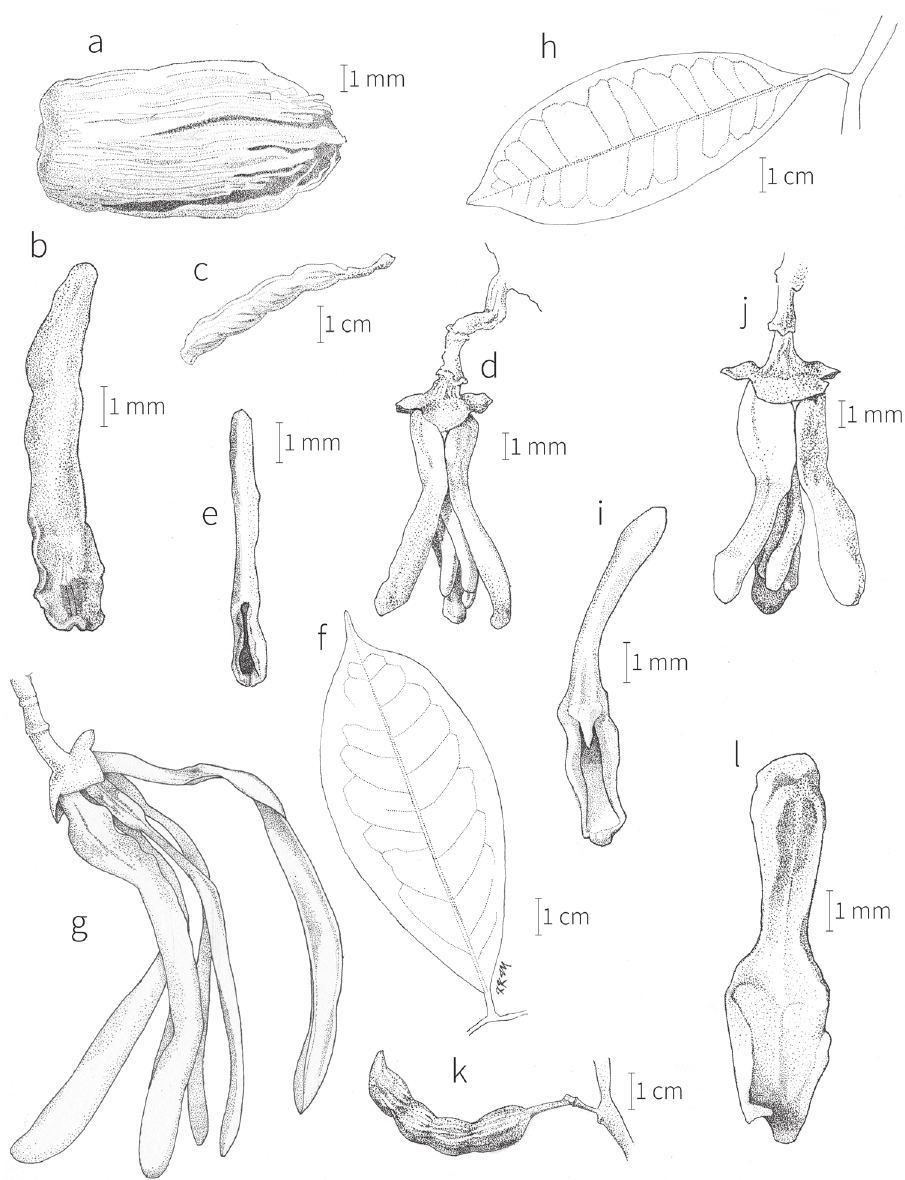
Figure 14. Xylopia quintasii , X. congolensis , and X. aurantiiodora . A–F X. quintasii A Seed, lateral view B Outer petal, adaxial view C Monocarp, lateral view D Flower, lateral view E Inner petal, adaxial view F Leaf G X. congolensis , flower, lateral view. H–K X. aurantiiodora H Leaf I Inner petal, adaxial view show- ing tooth J Flower, lateral view K Monocarp, attached to pedicel L Outer petal, adaxial view. A, C from Reitsma 1423 (WAG) B, D–F from de Wilde et al. 9156 (WAG) G from Tutin 80 (MO) H, K from Harris 752 (MO) I, J, L from Harris & Fay 1846